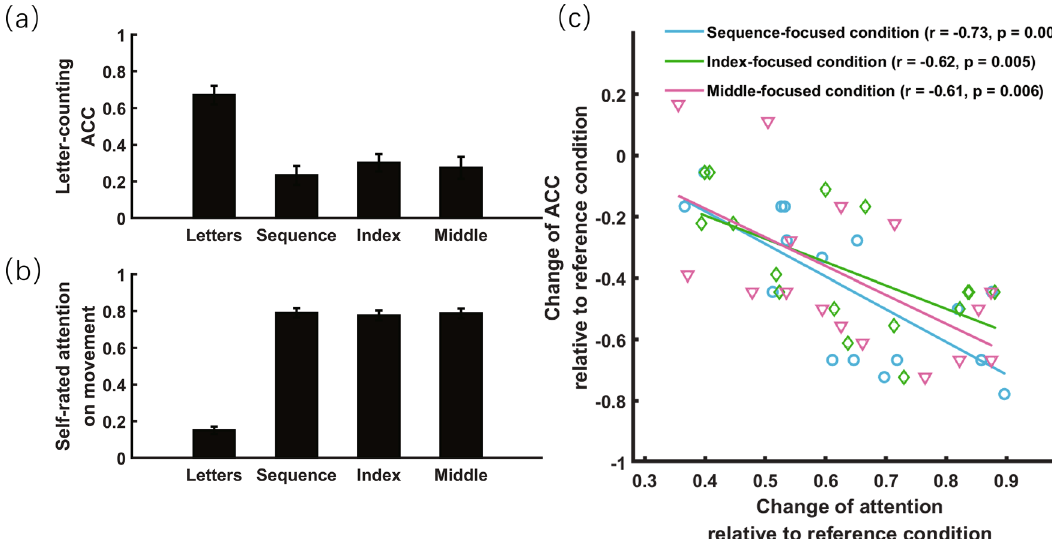
Figure 3. Objective and subjective measures of attention directed to finger-tapping movement in experiment 1. ( a ) Objective measure of attention: accuracy (ACC) of the secondary letter-counting task as a function of attentional focus. ( b ) Subjective measure of attention: self-rated amount of attention directed to movement as a function of attentional focus. ( c ) More attention directed to movement relative to the reference condition (letter- focused condition) led to less attention available for the secondary task, thus possibly contributing to more decrease in ACC of the secondary task. The error bar indicates one SEM.